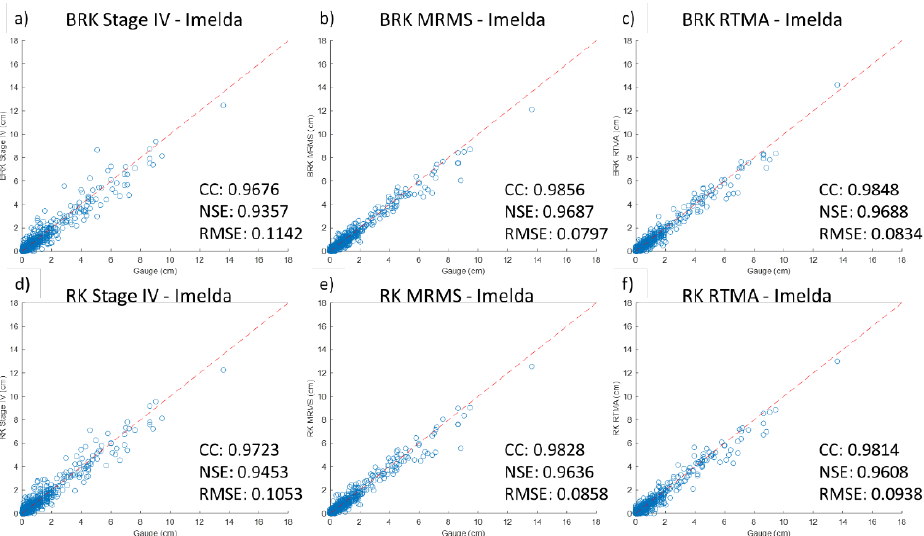
Figure 11. Scatter plots of validation gauge data and merged radar-gauge data of ( a ) Stage IV, ( b ) MRMS, ( c ) RTMA using the BRK method, ( d ) Stage IV, ( e ) MRMS, and ( f ) RTMA using the RK method during Tropical Storm